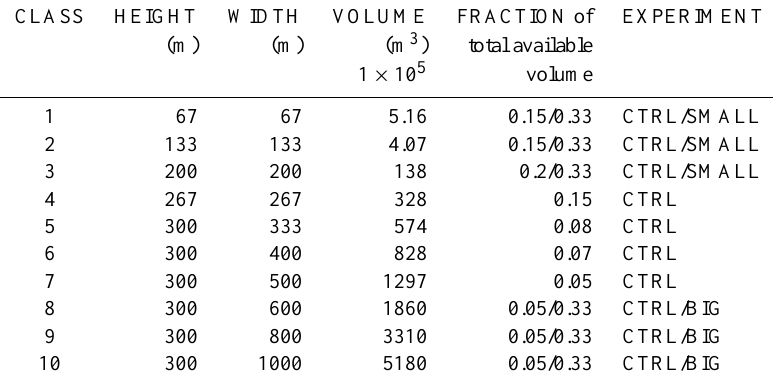
Table 2. Used initial iceberg